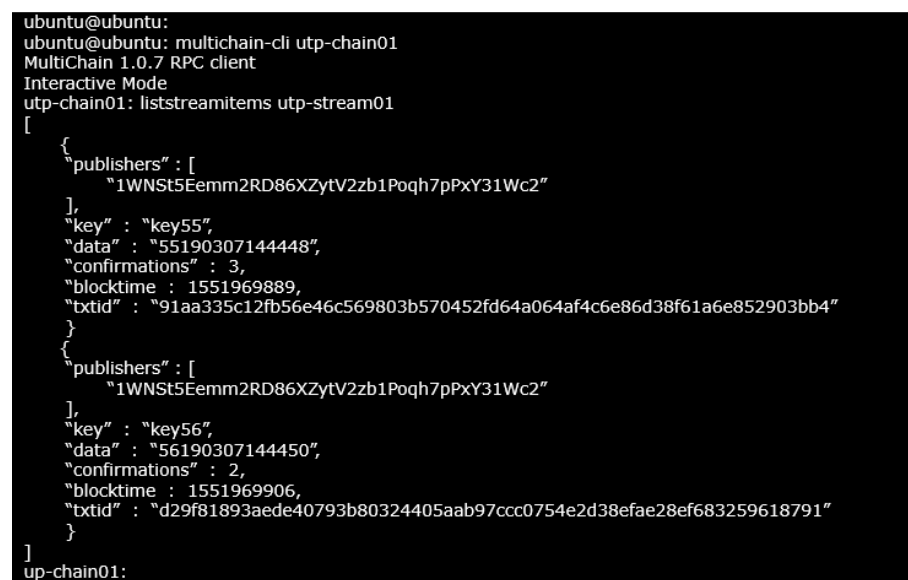
Figure 15. Transaction published to IoT blockchain retrievable and verified.